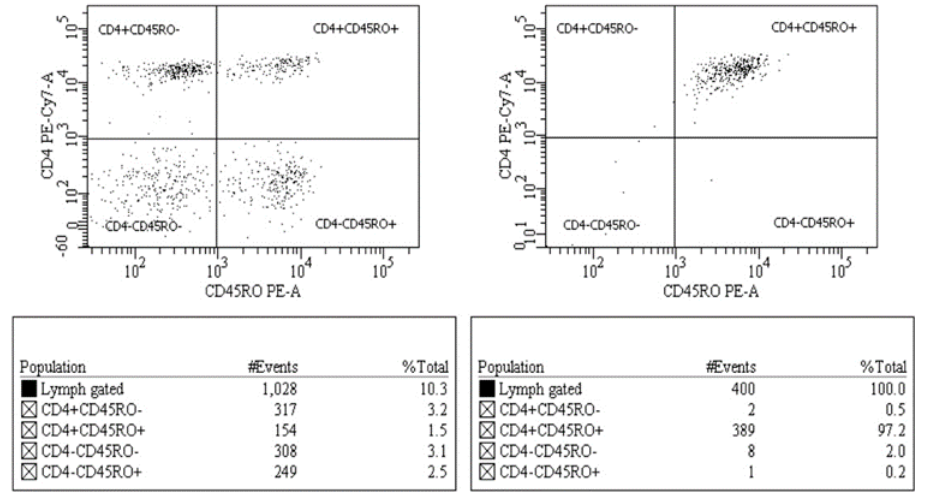
Figure 1. Analysis and cell sorting of CD4 + T-cells. The lymphocyte population was further identified as CD3 + CD4 + T-cells, each of which was then sub-classified into the memory (CD4 + CD45RA − RO + ) or naïve (CD4 + CD45RA + RO − ) subsets for cell-sorting. Purity of a sorted cell population was >95%.